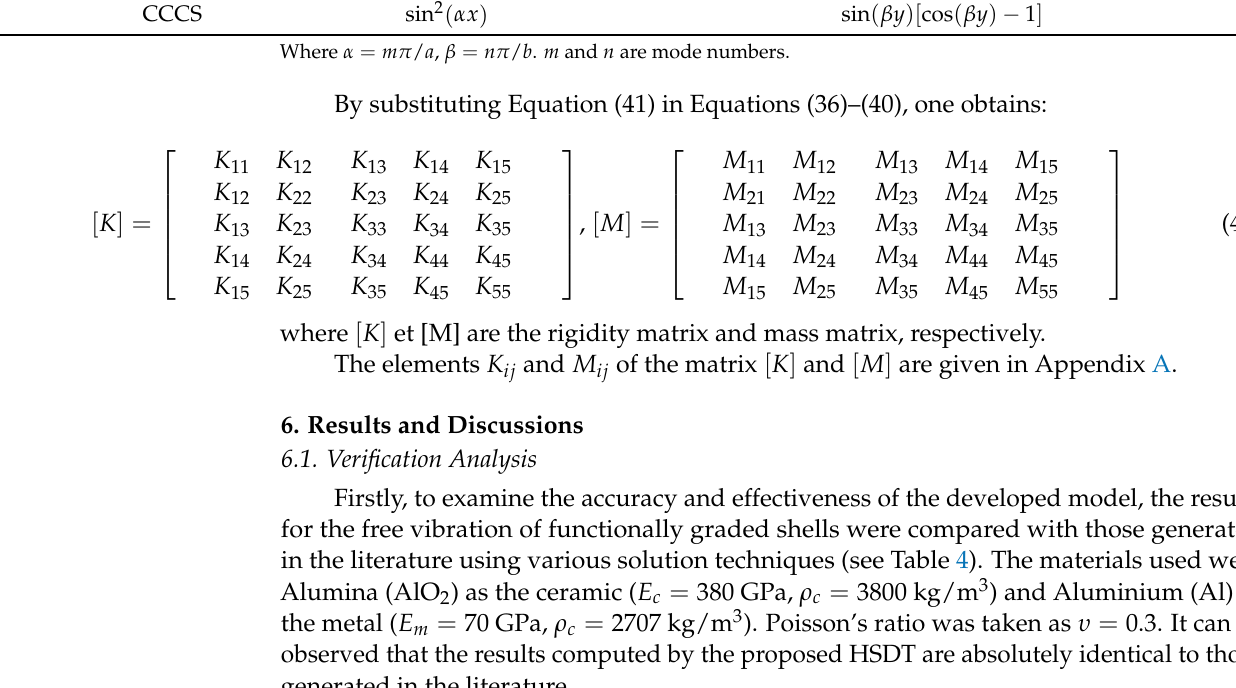
(cid:112) (cid:0) (cid:1) ρ c / E c for simply supported (cid:101) ω = ω h